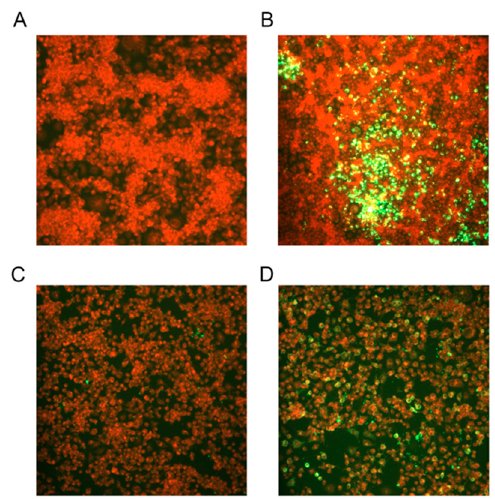
Figure 3. Immunofluorescence experiment. The recombinant virus was successfully rescued, as indicated by direct immunofluorescence, and the recombinant virus was labelled with a mouse anti-RABV N FITC-conjugated antibody. ( A , C ) BSR cell controls that were not infected with the recombinant virus lacked fluorescence. Green fluorescence in the cells indicates infection with the recombinant virus ( B ). The RVFV eGn protein in the recombinant virus was labelled with a mouse anti-RVFV Gn monoclonal antibody to identify the successful expression of RVFV eGn from the RABV vector ( D ).